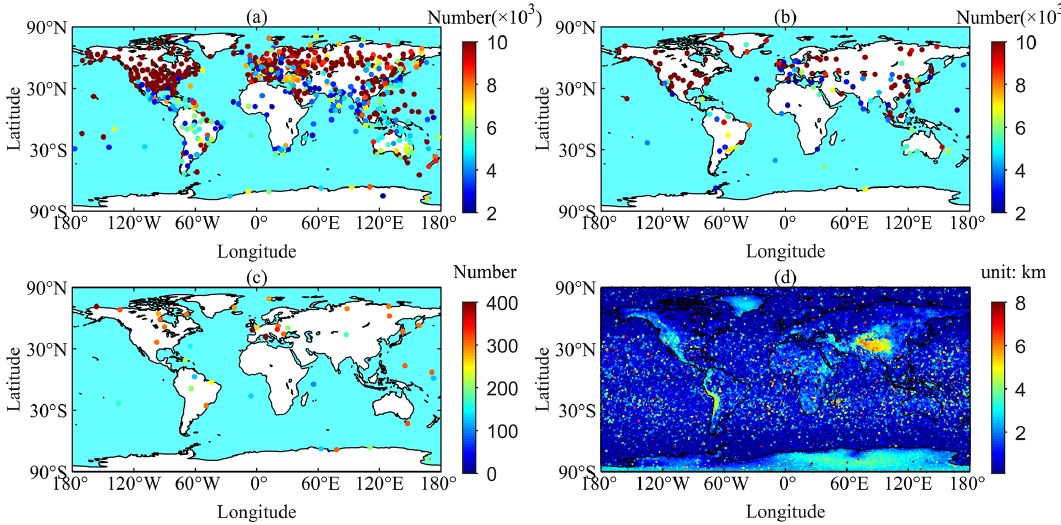
Figure 1. (a) Radiosonde stations for the development of the new model. (b) Radiosonde stations for testing the new model. (c) GNSS stations for evaluating the effect of the new model on real-time GNSS-derived PWV. (d) Profiles selected from COSMIC RO data. The color bars in (a) – (c) indicate the number of samples at each station, and the color bar in (d) denotes the penetration depth of each